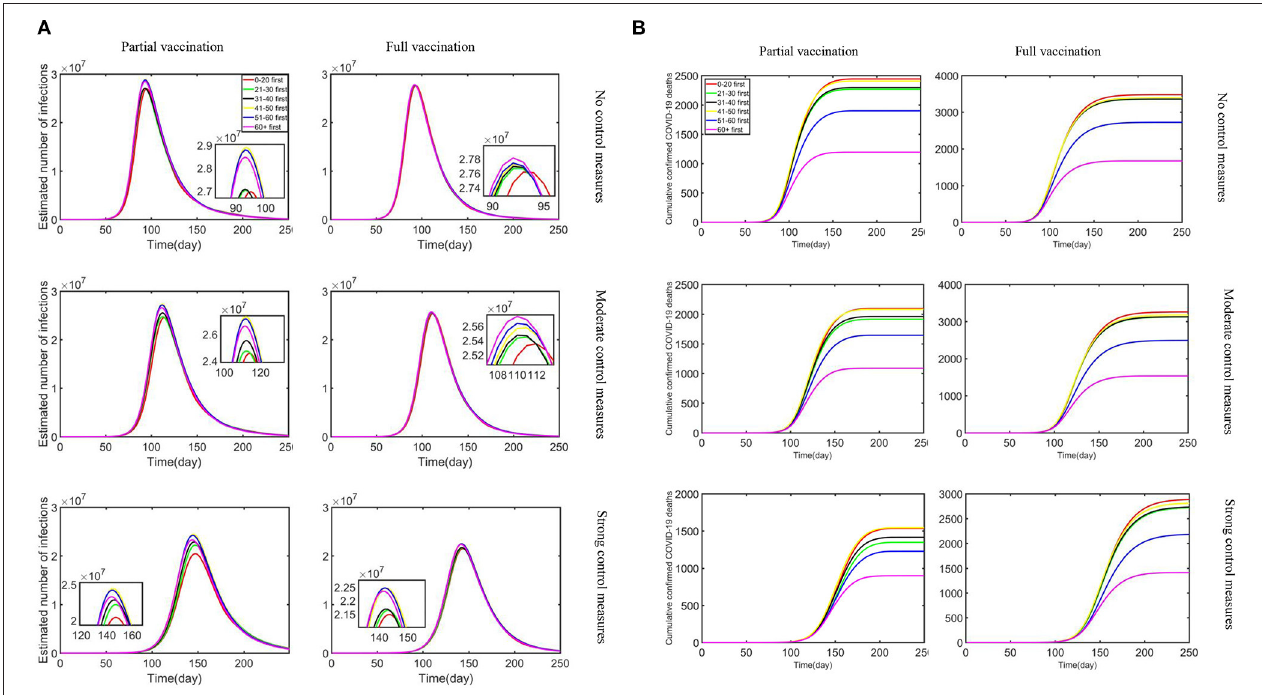
FIGURE 2 | The combined impact of different vaccine supply plans and control measures on reductions in the estimated number of infections and cumulative confirmed deaths: (A) estimated number of infections; (B) cumulative confirmed COVID-19